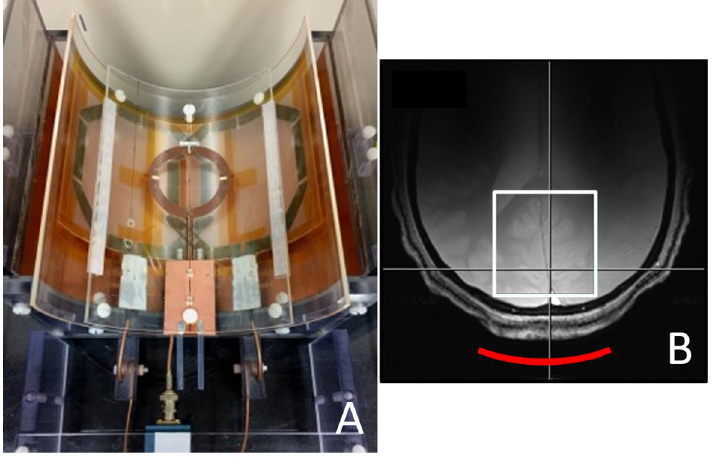
Fig 1. A 7 Tesla radio frequency (RF) coil assembly and its relative position to the human head. (A) The circular 31 P surface coil, the 1 H coil (two overlapping octagonal loops), and the RF shield were mounted on the bottom surface of the upper, middle, and lower tubes, respectively. Each proton loop had a 1 H cable trap constructed using an RG-316 cable. A 31 P cable trap, built inside an RF shielded box, was connected to the 31 P coil. (B) Gradient echo localizer image from a healthy volunteer showing the relative position of the 31 P surface coil (red arc, 7.5 cm dia.) and the shim voxel (5 x 5 x 5 cm 3 box in while